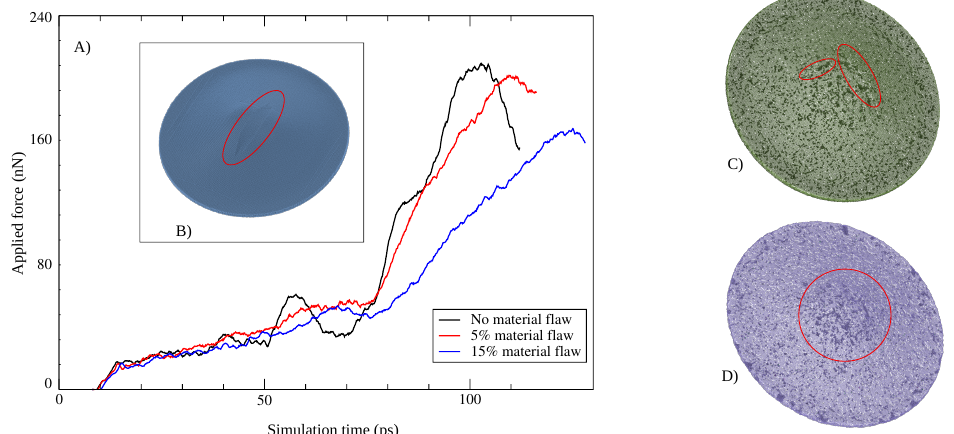
Figure 9. ( A ) Applied force versus simulation time. ( B ) Failure pattern of model with no material flaw, ( C ) with 5% material flaw, and ( D ) with 15% material flaw. The spluttered type of failure patterns were observed in the material flaw